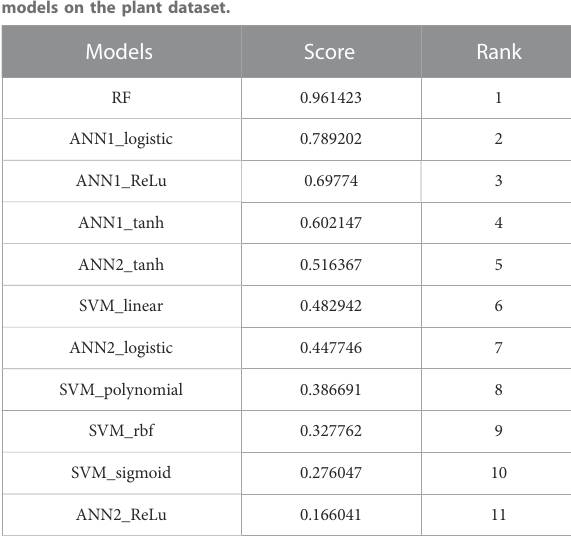
(Figure 7). From the above comparisons, Random Forest (RF) model perform comparatively better than the other ten models on plant datasets and got 1st rank according to TOPSIS analysis (Table 7).